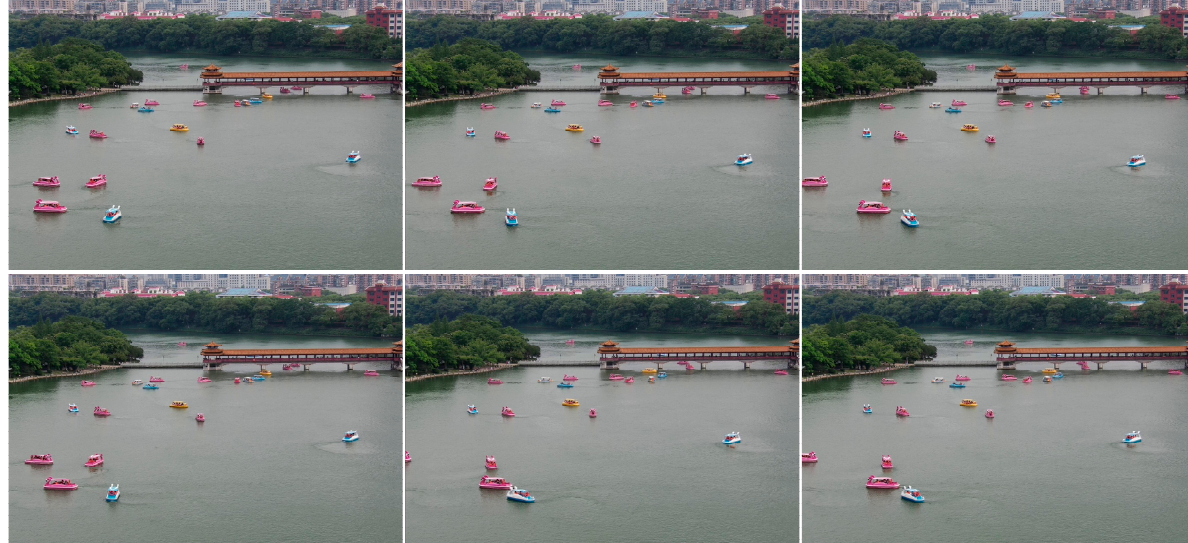
Figure 15. The custom dataset.